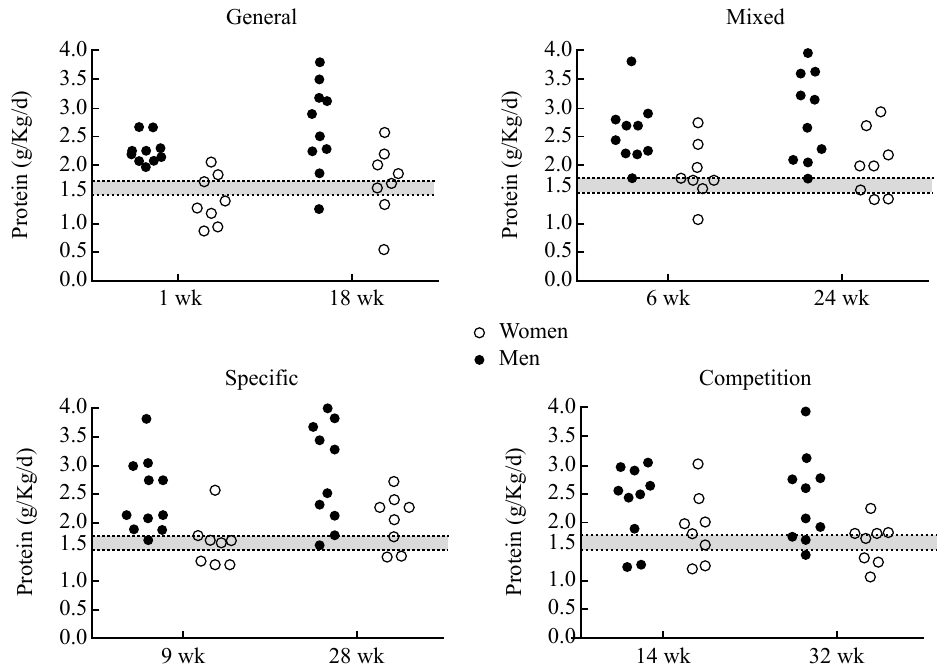
Figure 4. Individual protein intake and recommendation (grey band) for each training phase (in two macrocycles) by male (n=10) and female (n=8)